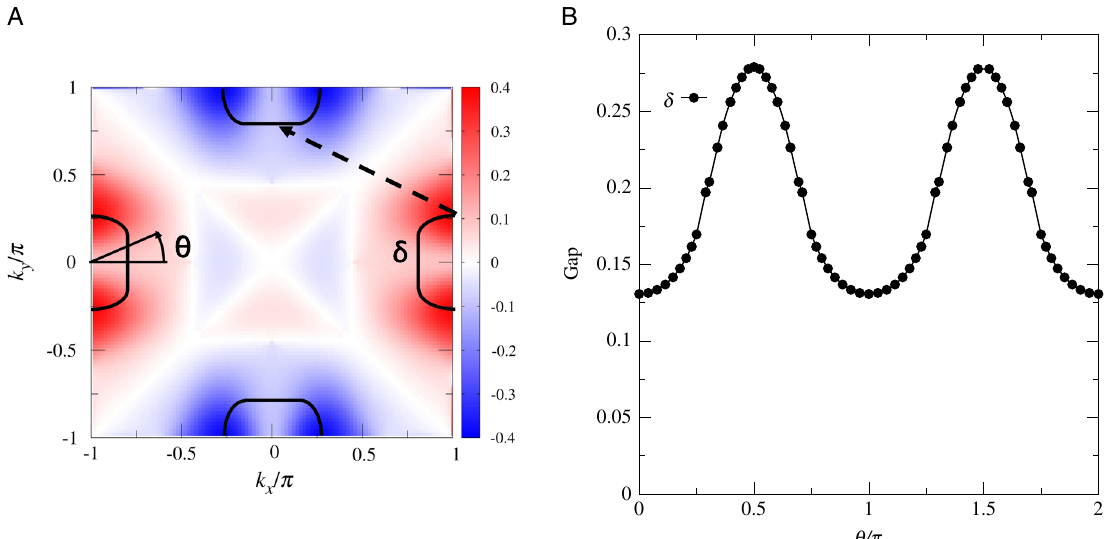
Fig. 4 a The FS ( solid line ) and the real intraband pairing for the band generating the δ pockets at the edge of the BZ for a dispersion typical of the alkaline iron selenides. Note the clear change in sign between pockets separated by the BZ diagonal. The dashed arrow indicates the q = ( π , π /2) wavevector associated with the resonance in the spin spectrum found in experiment. 50 b The size of the gap along the δ pocket. Both = 1.5, A = 0.3, and A = 0.9 with dominant s τ fi gures are for J 2 O L 3